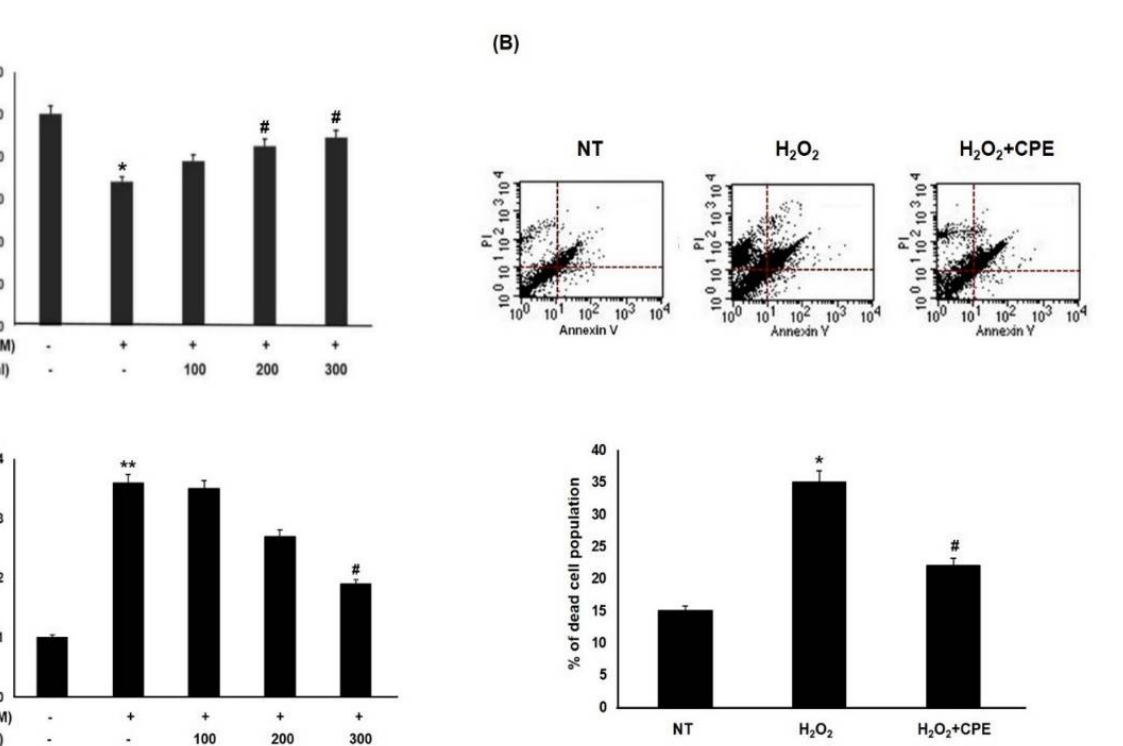
Figure 2. CPE protects melanocytes against H 2 O 2 -induced oxidative stress. ( A ) Melan-a cells were first treated with CPE and then with 0.5 mM H 2 O 2 for 24 h. The cell viability was determined with an MTT assay. ( B ) The apoptotic ratio was measured by flow cytometry though Annexin V/PI double staining. ( C ) The fluorescence intensity of the DCF-stained cells for each condition was quantified. All data are shown as the means ± SDs of at least three independent experiments (* p < 0.05, ** p < 0.01 vs. NT, # p < 0.05 vs. H 2 O 2 treated cells).